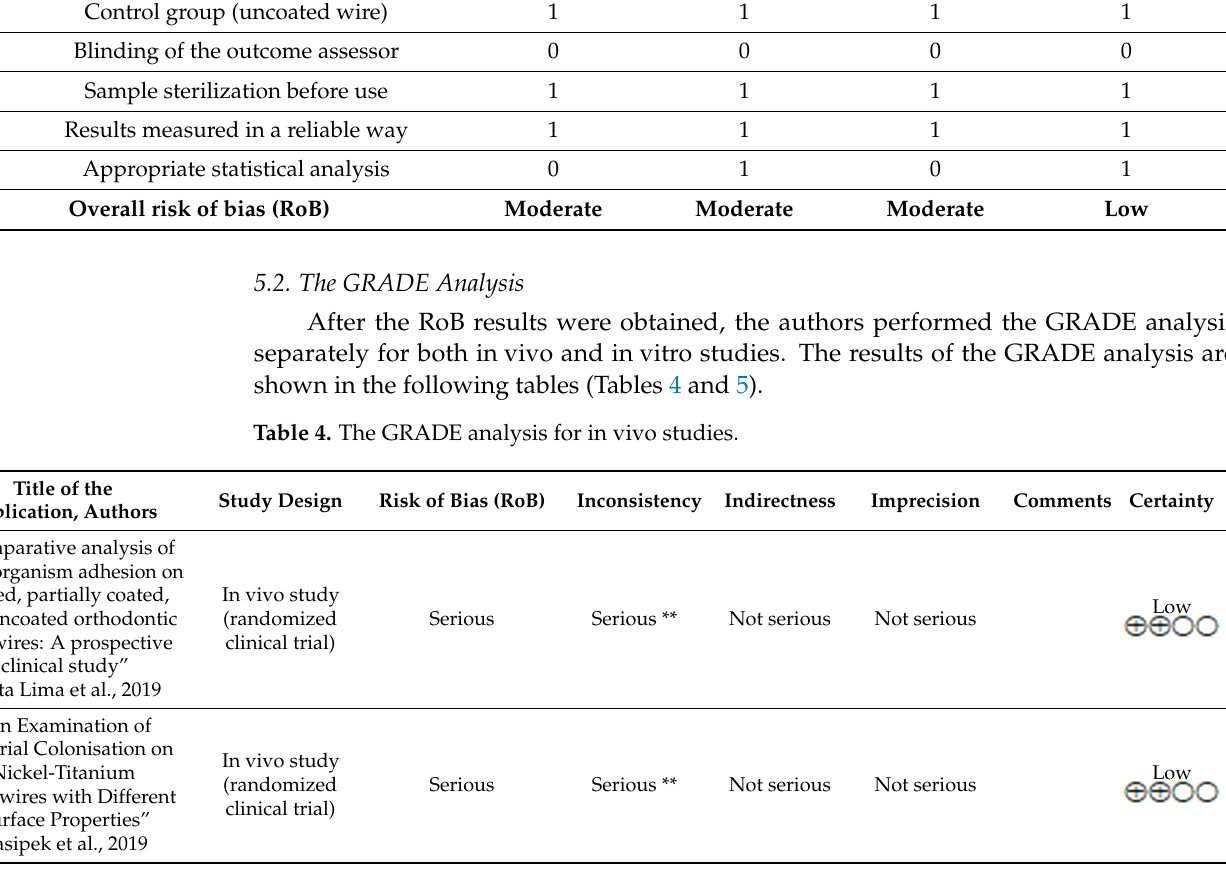
Table 4. The GRADE analysis for in vivo